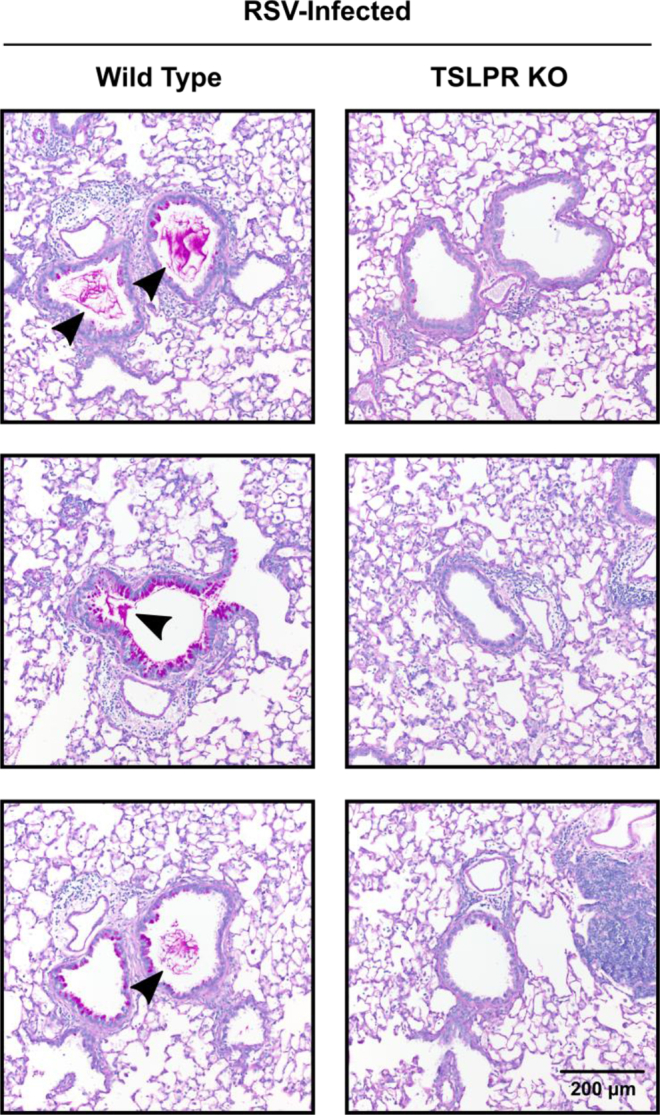
Supplementary histopathologic sections from WT and TSLPR-deficient mice at day 6 after infection. WT or TSLPR KO mice were infected with 3 × 106 PFU of RSV strain 01/2-20. Additional representative PAS-stained sections of mucus-containing airways in the lungs on day 6 after infection (×20 magnification). The arrowhead denotes intraluminal mucus plugging.